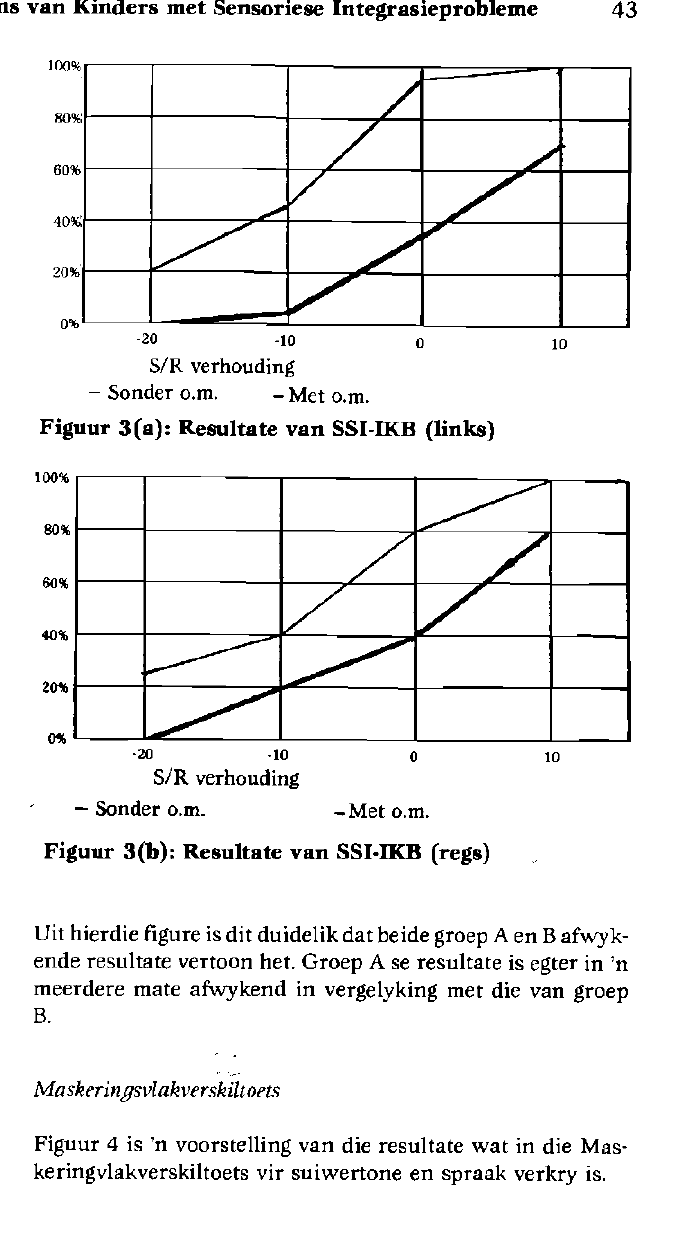
RESULTATE - MASKERINGSVLAKVERSKILTOETS